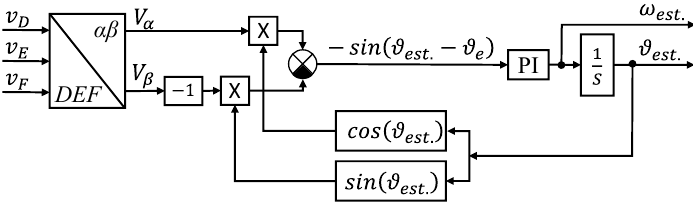
Figure 2. Emergency detection unit of the rotor speed/position.